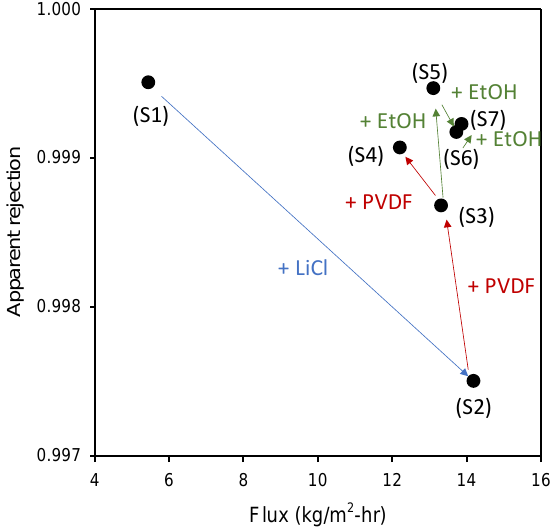
Figure 8. Changes in flux and apparent rejection with membrane fabrication conditions: An overview.